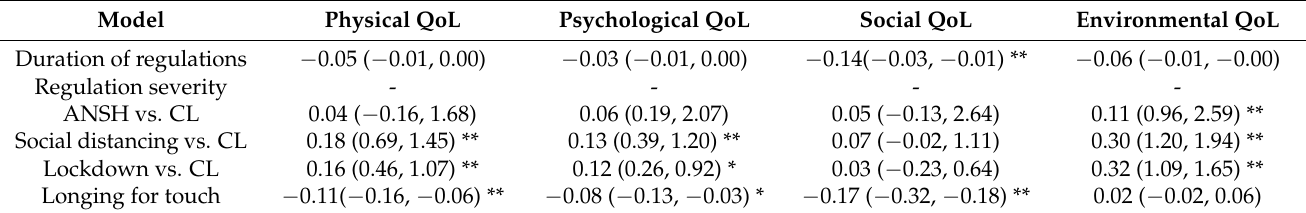
Table 2. Regression